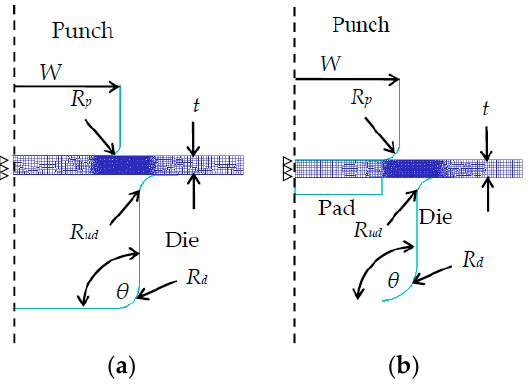
Figure 1. Finite element method (FEM) simulation model: ( a ) without pressure pad and ( b ) with pressure pad.